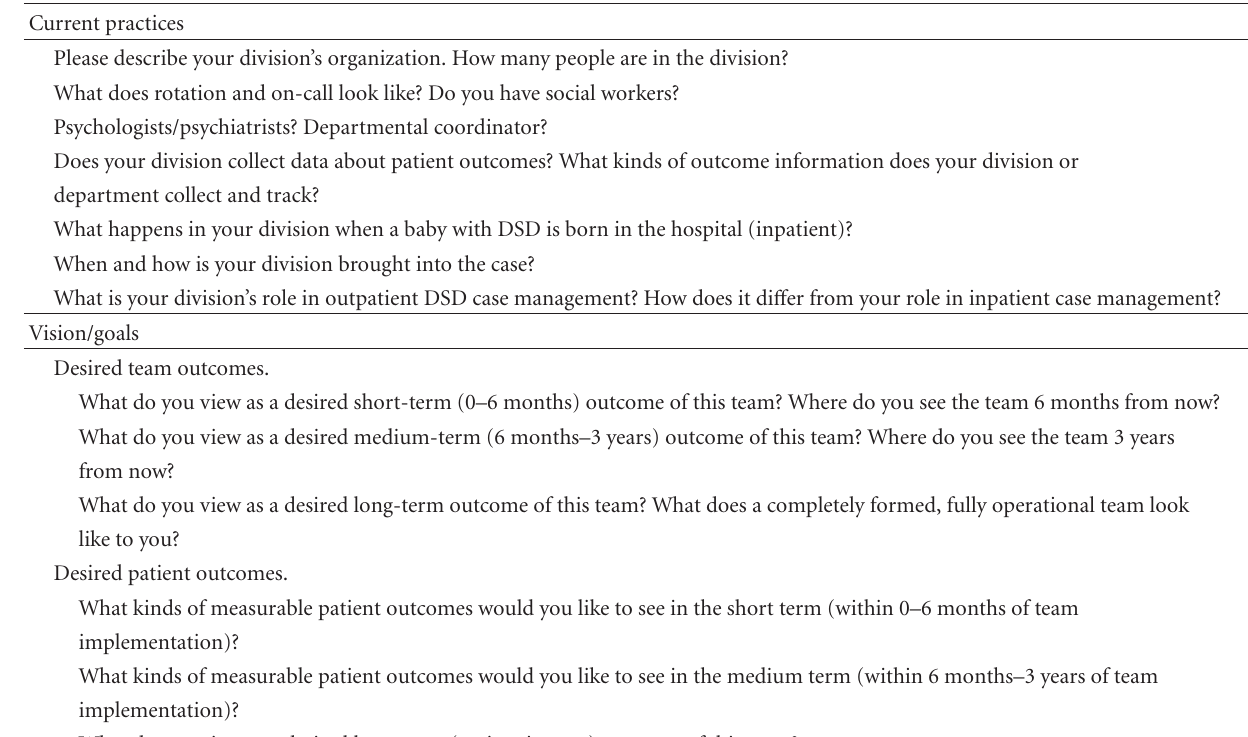
Table 1: Sample team member